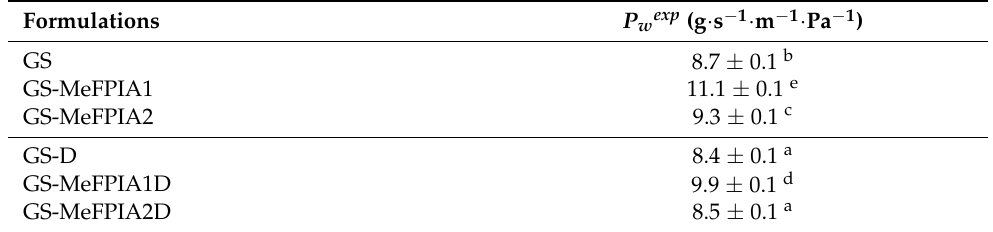
Table 4. Experimental water vapor permeability values of gelatin-based films.